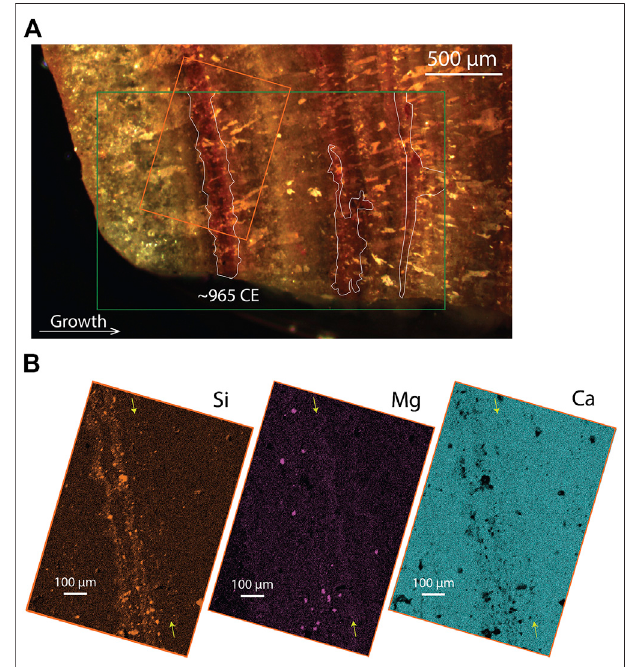
FIGURE 7 | Optical and electron microprobe analyses of a speleothem region covering the magnetically enriched 965 CE lamination. (A) Re fl ected light photomicrograph with crossed polarizers. Green box denotes the QDM fi eld of view shown in Figure 5 . Thin white outlines indicate the strongly magnetized regions. (B) EDS elemental composition maps of the orange boxed region in panel (A) . Yellow arrows indicate position of zone with enriched Mg in all three maps.